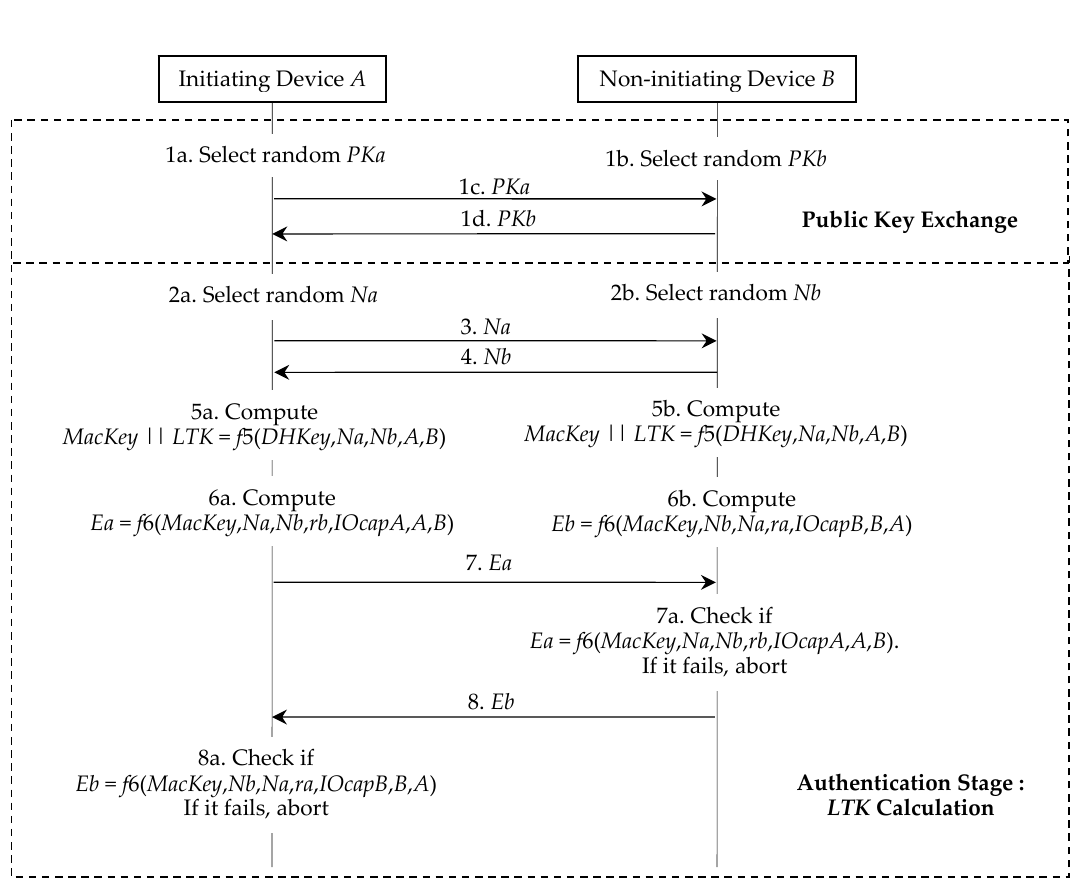
Figure 11. Aggressive LESSP protocol Π ’’.